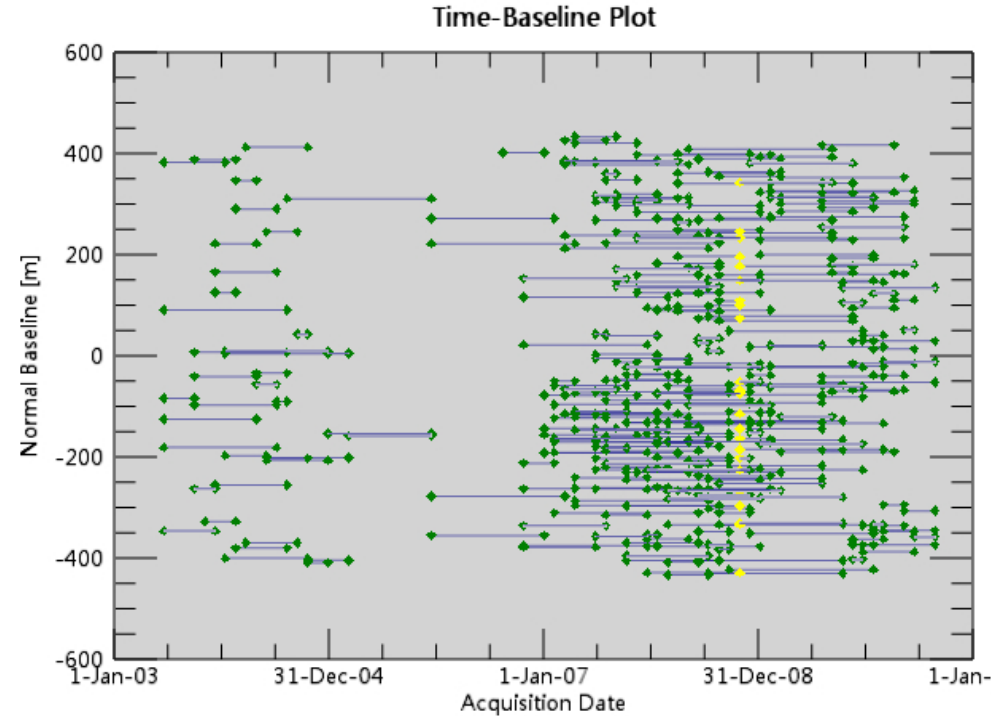
Figure 2. Time-baseline plots relevant to the ASAR images and interferograms used in this study. The green points represent the 52 ASAR acquisition dates. The yellow point represents the super master image acquisition